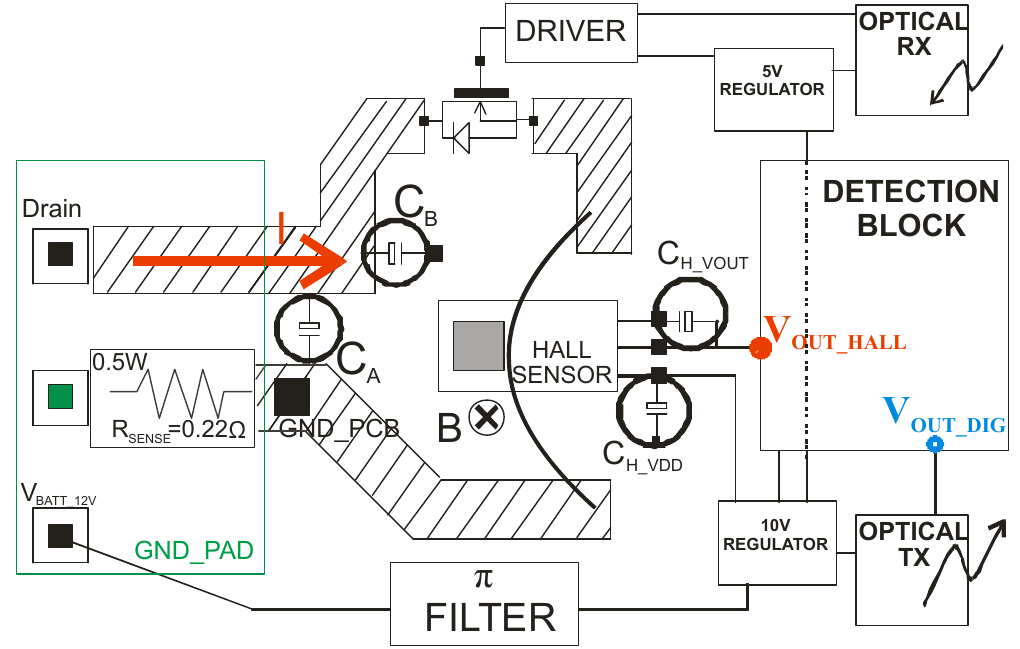
Figure 2. Layout representation of the testing